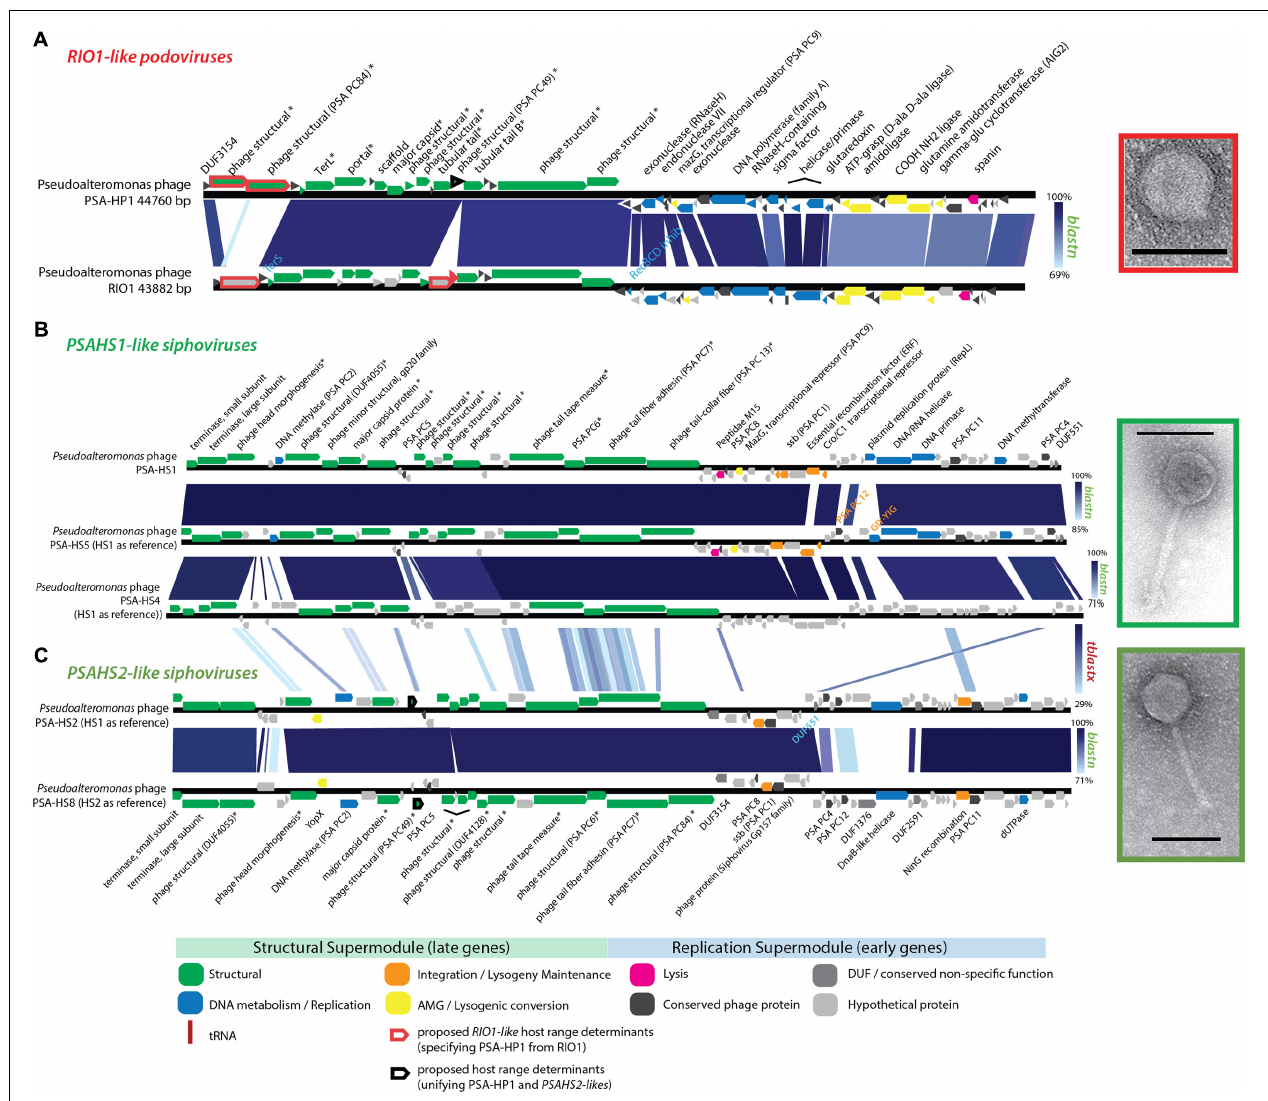
FIGURE 4 | (A) Full-genome comparison of PSA-HP1 and Pseudoalteromonas phage RIO-1 (East Sea, South Korea; Hardies et al., 2013) based on BLASTN similarity. Red outline indicates the five structural proteins not shared between PSA-HP1 and RIO1 that are implicated in their host range determination. Black outline indicates genes shared with RIO1-like phages and PSAHS2-like phages, but not with the PSAHS1-like phages. (B) Full-genome comparison of the three Helgoland phages belonging to the PSAHS1-like phage genus based on BLASTN similarity. (C) Full-genome comparison of the two Helgoland phages belonging to the PSAHS2-like phage genus based on BLASTN similarity. Connections between (B,C) indicate similarity between the PSAHS1-like and PSAHS2-like genera based on TBLASTX analysis. ∗ Denotes proteins confirmed as structural by mass spectroscopy-based